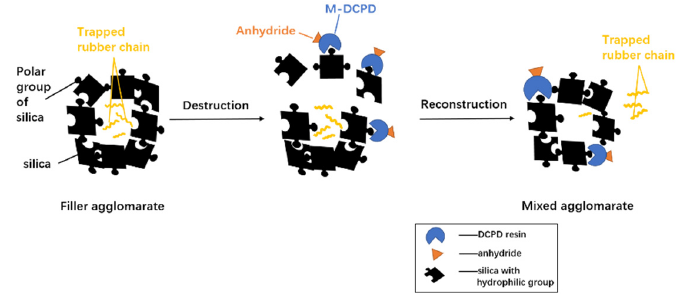
Figure 5 . Schematic of the interaction between modified resin and silica. Figure 5. Schematic of the interaction between modified resin and